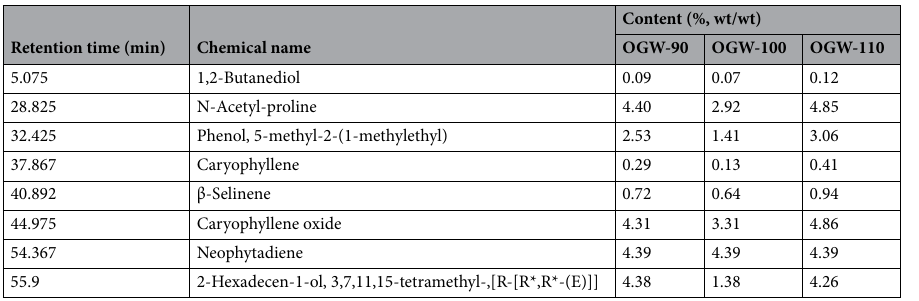
Table 3. Chemical composition of O. gratissimum water extract.